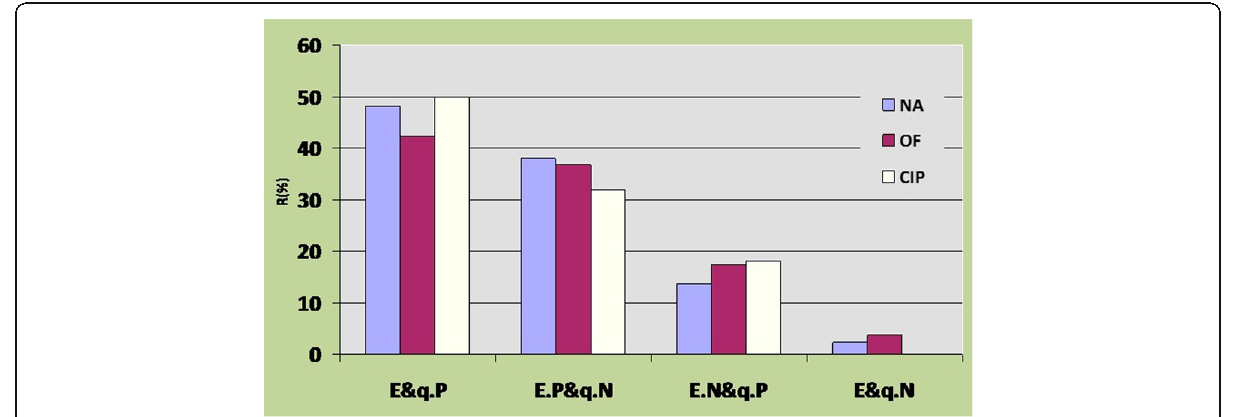
Fig. 3 Quinolone resistance pattern of ESBL-producing Escherichia coli isolates harboring qnr genes. Left to right: E&q.P, ESBL and qnr positive; E.P&q.N, ESBL positive and qnr negative; E.N&q.P, ESBL negative and qnr positive; E&q.N, ESBL and qnr negative